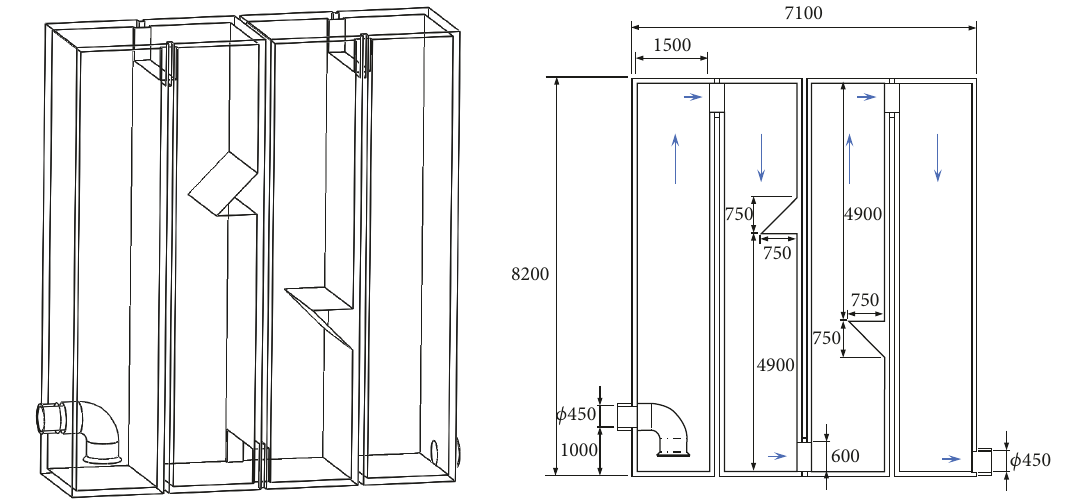
Figure 6: Projected view and schematic of final (fourth) decay tank